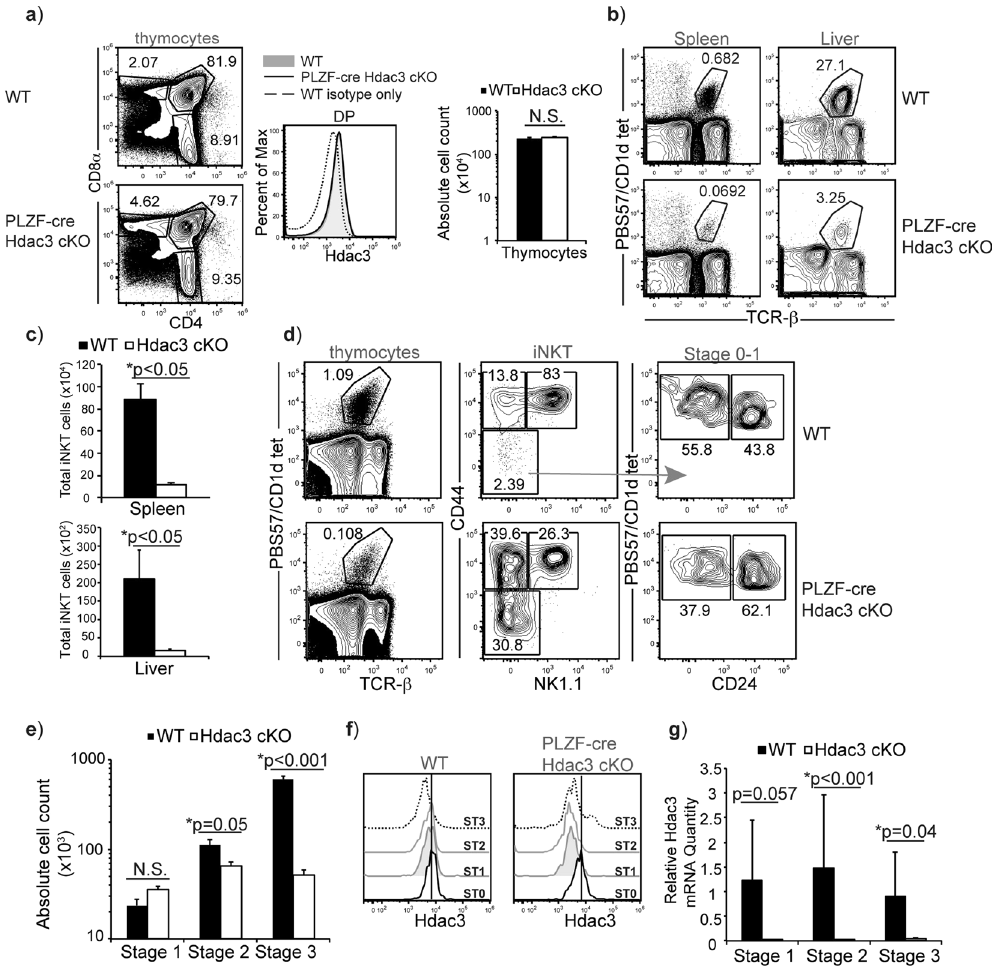
Figure 1. Hdac3 is required for iNKT cell development. ( a ) CD4/CD8 profile in thymocytes from WT and PLZF-cre Hdac3 cKO mice. Hdac3 expression in DP thymocytes from WT and PLZF-cre Hdac3 cKO mice as well as isotype control in WT mice is shown. Data is representative of at least 5 mice/genotype from 4 independent experiments. Absolute cell count of thymocytes from WT and PLZF-cre Hdac3 cKO mice. Data is calculated from 21 WT and 12 PLZF-cre Hdac3 cKO mice. ( b ) Representative frequencies of iNKT cells in spleen and liver. Data is representative of at least 5 mice/genotype. ( c ) Quantification of absolute cell number of iNKT cells (CD1d:PBS57 tetramer + TCR- β med ) from spleen and liver of WT and PLZF-cre Hdac3 cKO mice. Data is calculated from 7 mice/genotype (spleen) and 5 mice/genotype (liver) from 3 independent experiments. ( d ) FACS analysis of thymic iNKT cells in developmental stages was performed using CD24, CD44 and NK1.1: Stage 0 (CD24 + CD44 − NK1.1 − ), Stage 1 (CD24 − CD44 lo NK1.1 − ), Stage 2 (CD24 − CD44 hi NK1.1 − ), and Stage 3 (CD24 − CD44 + NK1.1 + ). Data is representative of at least 12 mice per genotype. ( e ) Absolute cell count of thymic iNKT cells at Stage 1, Stage 2 and Stage 3. Average is calculated from 21 WT and 12 PLZF-cre Hdac3 cKO mice from 6–10 weeks of age. ( f ) Overlay of expression of Hdac3 in Stage 0–3 iNKT cells from WT and PLZF- cre Hdac3 cKO mice. Data is representative of at least 6 mice per genotype from 5 independent experiments. Stage 0: black line, Stage 1, grey filled, Stage 2: grey line, Stage 3: dashed line. Black vertical line represents peak of Hdac3 expression in WT and PLZF-cre Hdac3 cKO Stage 0 iNKT cells. ( g ) Relative expression of Hdac3 mRNA in sorted iNKT cells in WT and PLZF-cre Hdac3 cKO using q-PCR. Data was normalized to expression of Hdac3 in WT Stage 3 iNKT cells ( = 1). Data is calculated from 3 WT and 5 PLZF-cre Hdac3 cKO mice from 3 independent sorts. Statistical analysis was performed using a Student t test. Means ±